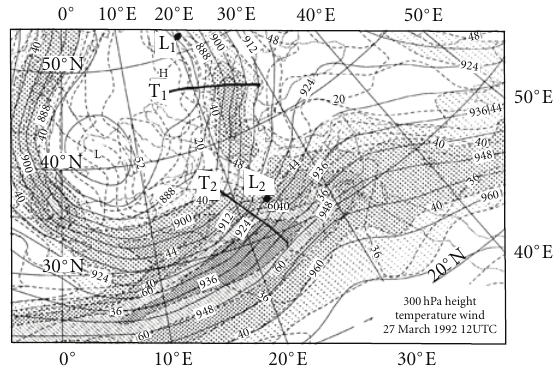
Figure 6: Objective analysis of geopotential height, temperature, and jet stream axes for 300 hpa on 27 March 1992/12:00 UTC. Geopotential contours: every 60 gpm, isotherms: every 2 ◦ C, and jet stream axes denote wind speed more or equal to 30ms − 1 ; T 1 and T 2 are trough lines and L 1 and L 2 the surface depression